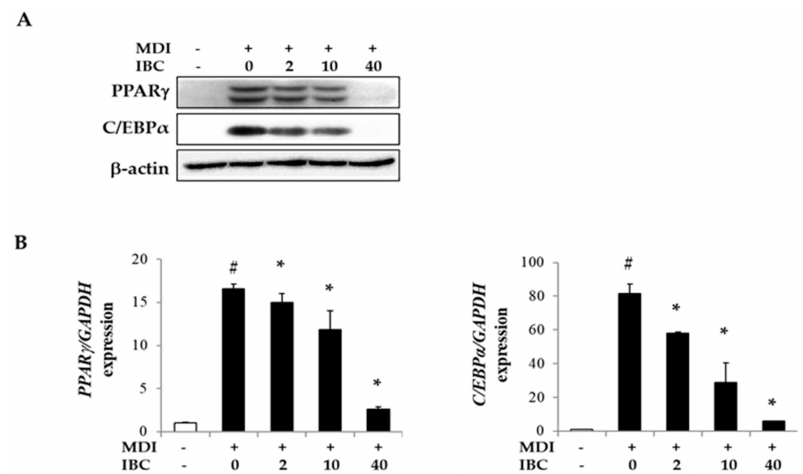
Figure 3. Inhibitory effect of IBC on expression of adipogenic transcription factors. 3T3-L1 adipocytes were differentiated with IBC at indicated concentrations. On D5, cells were harvested and lysed to perform Western blotting analysis ( A ) and quantitative real time PCR (qPCR) ( B ). Data are presented as means ± SD of triplicate experiments. # p < 0.01 vs. control; * p < 0.01 vs. MDI only.